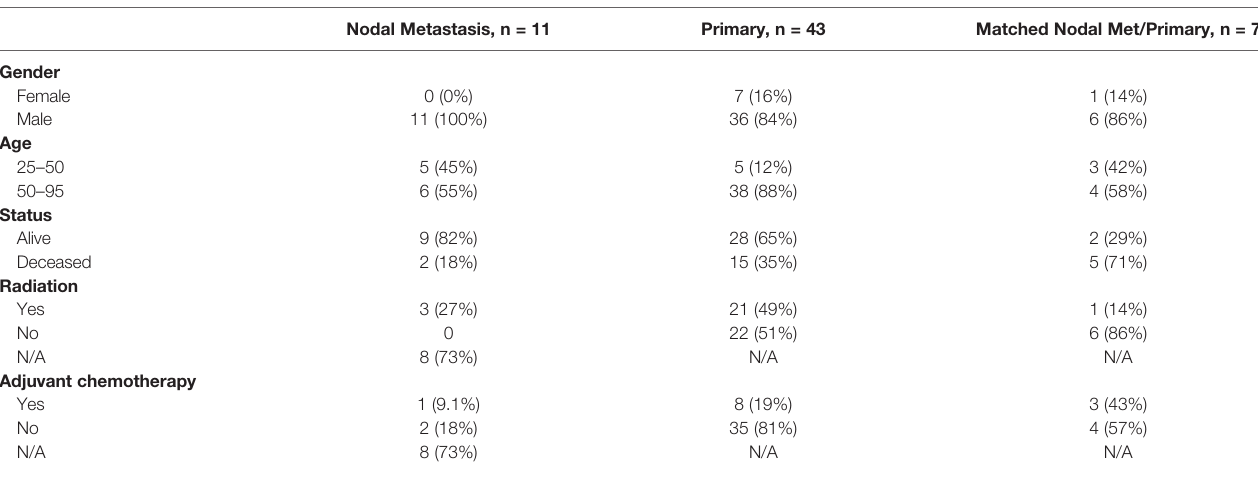
TABLE 1 | OPSCC cohort